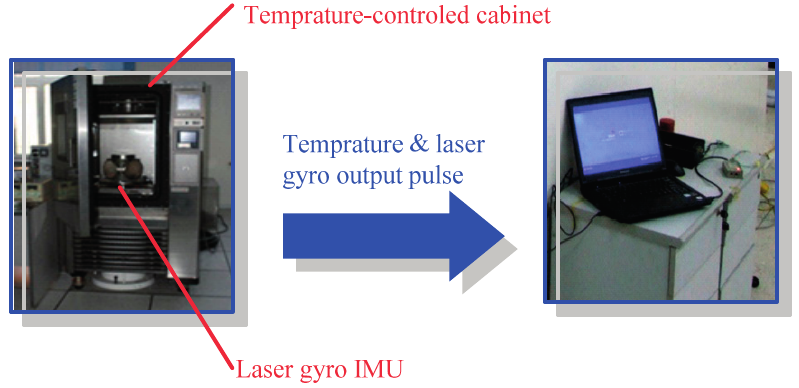
Figure 4. Data collection experiment